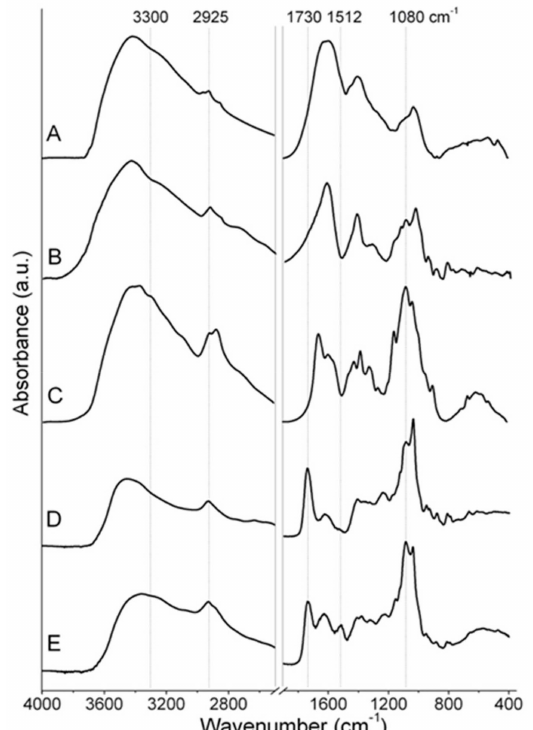
Figure 2. FTIR spectra of ( A ) BBS-GC, ( B ) sodium alginate, ( C ) chitosan, ( D ) F-Alg / Chito and ( E ) F-Alg / Chito / BBS. Dotted lines evidence the position of some significant signals described in the main